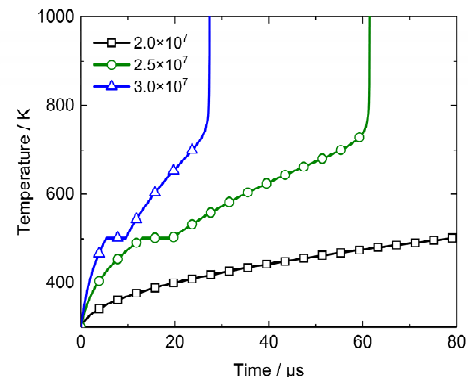
Figure 8. Temperature histories on a microcrack surface with different boundary heat flows. Figure 9. In view of symmetry, only the temperature on one side of the microcrack surface is plotted. The horizontal axis is the ratio of the distance to the microcrack surface to the micorcrack radius. Figure 9 indicates that the frictional heat accumulates near the microcrack surface and leads to temperature increase. The maximum of the temperature is on the microcrack surface. The